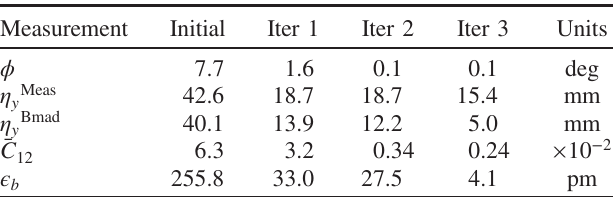
TABLE V. 95% C.L. correction levels after each correction Bmad include observational effects iteration. All values except η y from BPM measurement errors. Details of the correction iter- ations are discussed in Sec. VI.